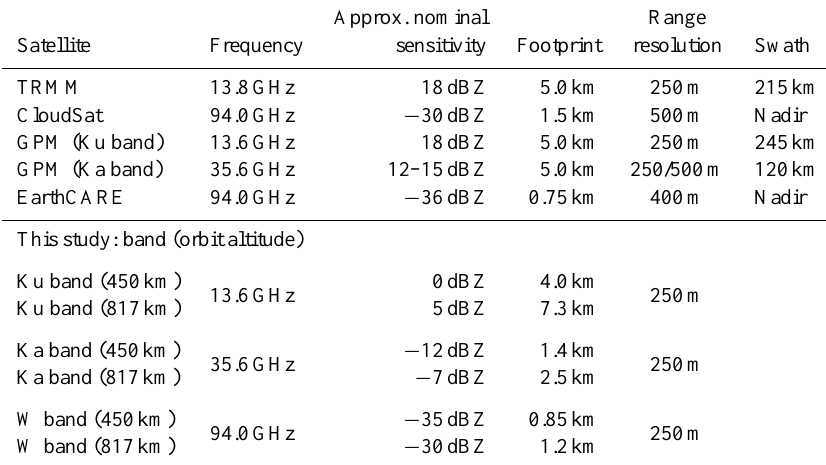
Table 1. Summary of approximate specifications of current and upcoming spaceborne radars, with comparison to the configuration examined in this study. The TRMM specifications are values after the 2001 orbital boost and before the exhaustion of propellant in 2014. The footprint of the W-band channel at the 450km configuration is limited by the resolution of the NICAM model. Approx.